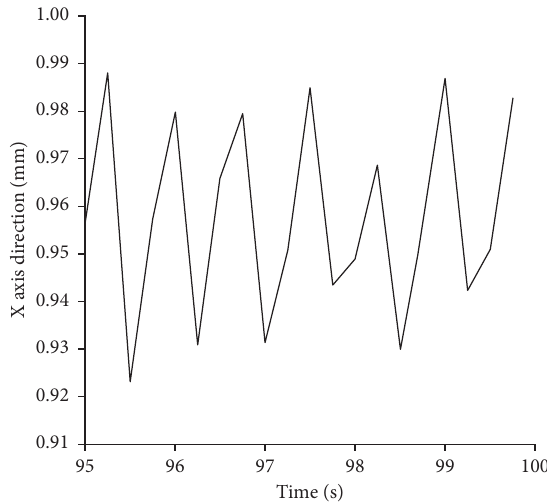
Figure 8: The displacement of the thermowell vertex in X-axis under stable state.